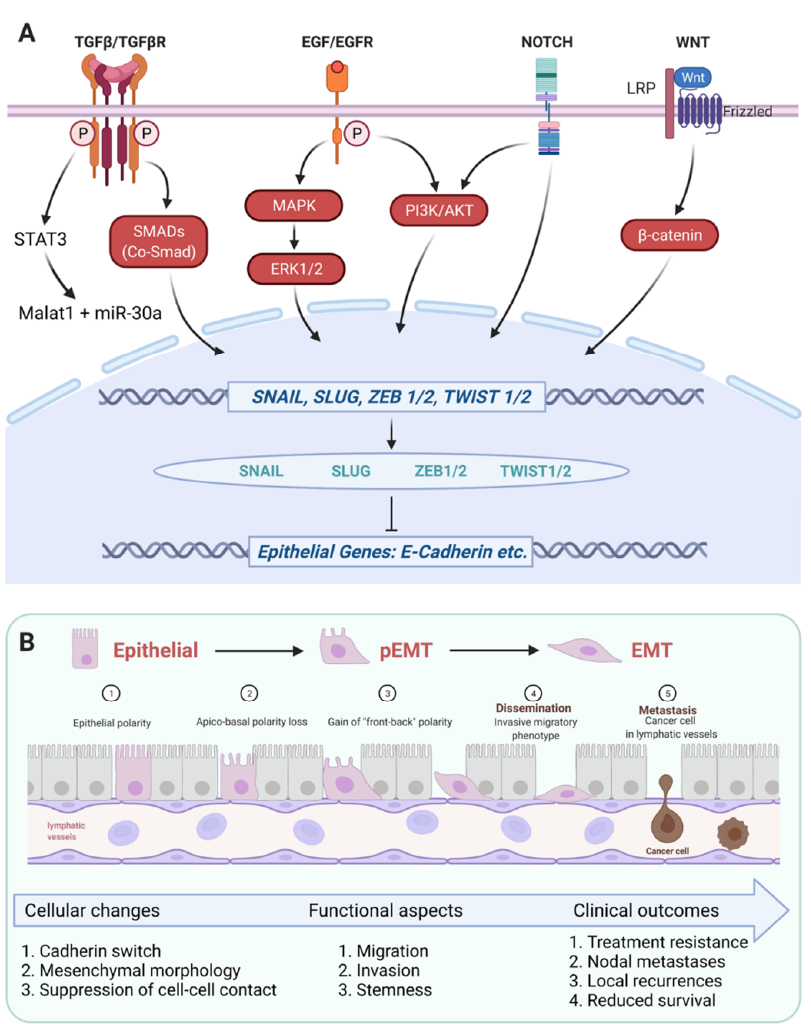
Figure 2. Schematic representation of central signaling pathways involved in the induction of (partial) EMT in HNSCC. ( A ) Figure 2A depicts major ligands, receptors, signaling components (red color) and transcription factors involved in the induction of EMT and partial EMT (genes are depicted in blue color, proteins in green color) via the repression of epithelial genes (depicted in blue color). TGF β R, EGFR, NOTCH, and LRP/Frizzled receptors have been reported to induce the expression of EMT-TFs SNAIL, SLUG, ZEB1/2, and TWIST1/2 through the binding of their cognate ligands, i.e., TGF β , EGF, Delta/Jagged or mutations, and WNT variants, respectively. TGF β R signaling towards EMT is functional via signal transducer and activator of transcription 3 (STAT3) and the subsequent induction of Malat1 and miR-30a, and via SMADs/co-SMAD. Activation of EMT through EGF/EGFR was reported to depend primarily on MAPK and ERK1/2; however, induction via PI3K and AKT was described too. Uncleavable mutated variants of NOTCH receptors were shown to trans-activate EGFR signaling at the level of PI3K and AKT, converging in EMT induction. WNT signaling via the Frizzled/LRP receptors result in nuclear translocation of β -catenin. ( B ) Figure 2B depicts the cellular, functional, and clinical consequences of the induction of (p)EMT described in Figure 2A. Molecular and cellular changes associated with (p)EMT include a progressive transit from an epithelial polarity ( 1 (cid:13) ) to a loss of apico-basal polarity ( 2 (cid:13) ) and a gain of “front-back polarity” ( 3 (cid:13) ), a switch in cadherin variants expression from E-cadherin to N-cadherin, the adoption of a mesenchymal morphology due to a suppression of cell–cell contacts. As a result, cells in EMT are characterized by enhanced migration, invasion, and stem-like properties ( 4 (cid:13) ) that influence treatment resistance, metastases formation ( 5 (cid:13) ), and recurrences, and thereby affect the clinical outcome of HNSCC patients (Figure generated using BioRender, Toronto, ON,